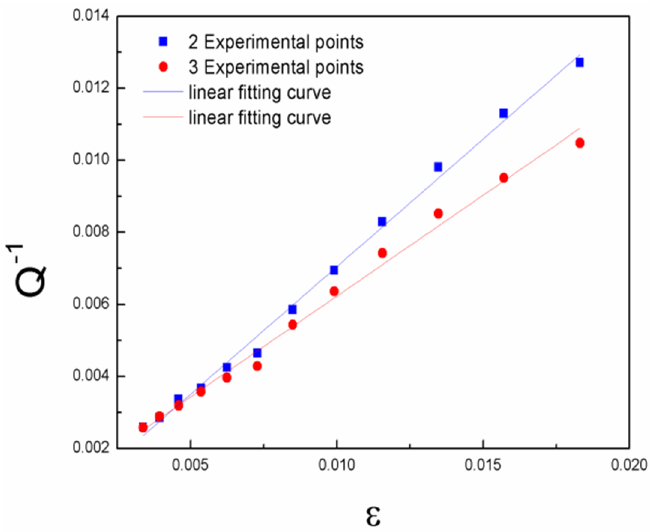
Figure 11. Damping–strain fitting curves for samples 2 and 3.